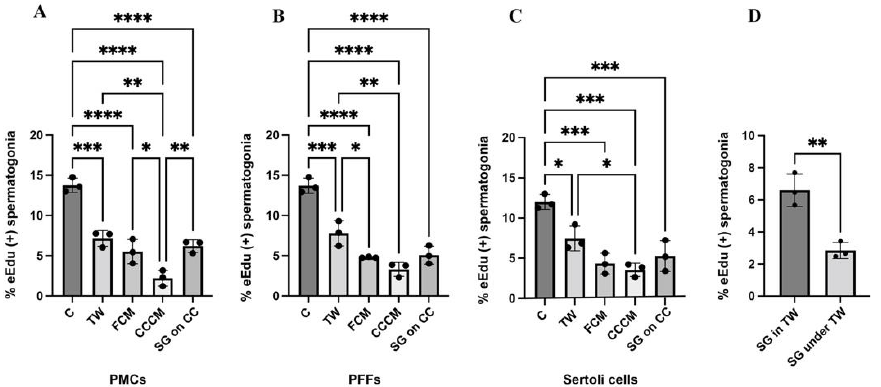
Figure 5. The proliferation of spermatogonia is higher in the presence of feeders than in feeder-free conditions, using conditioned media. Proliferation rates of spermatogonia grown in contact (C), in transwells (TW), using feeder-conditioned media (FCM), using co-culture conditioned media (CCCM), and grown in transwells on top of co-cultures (SG on CC) using ( A ) PMCs, ( B ) PFFs, and ( C ) Sertoli cells. ( D ) Proliferation of spermatogonia cultured feeder-free in transwells (SG in TW) and under transwells (SG under TW). Data are presented as mean ± SD (n = 3). A p -value of < 0.05 was considered significant (* p ≤ 0.05, ** p ≤ 0.01, *** p ≤ 0.001, **** p ≤ 0.0001).